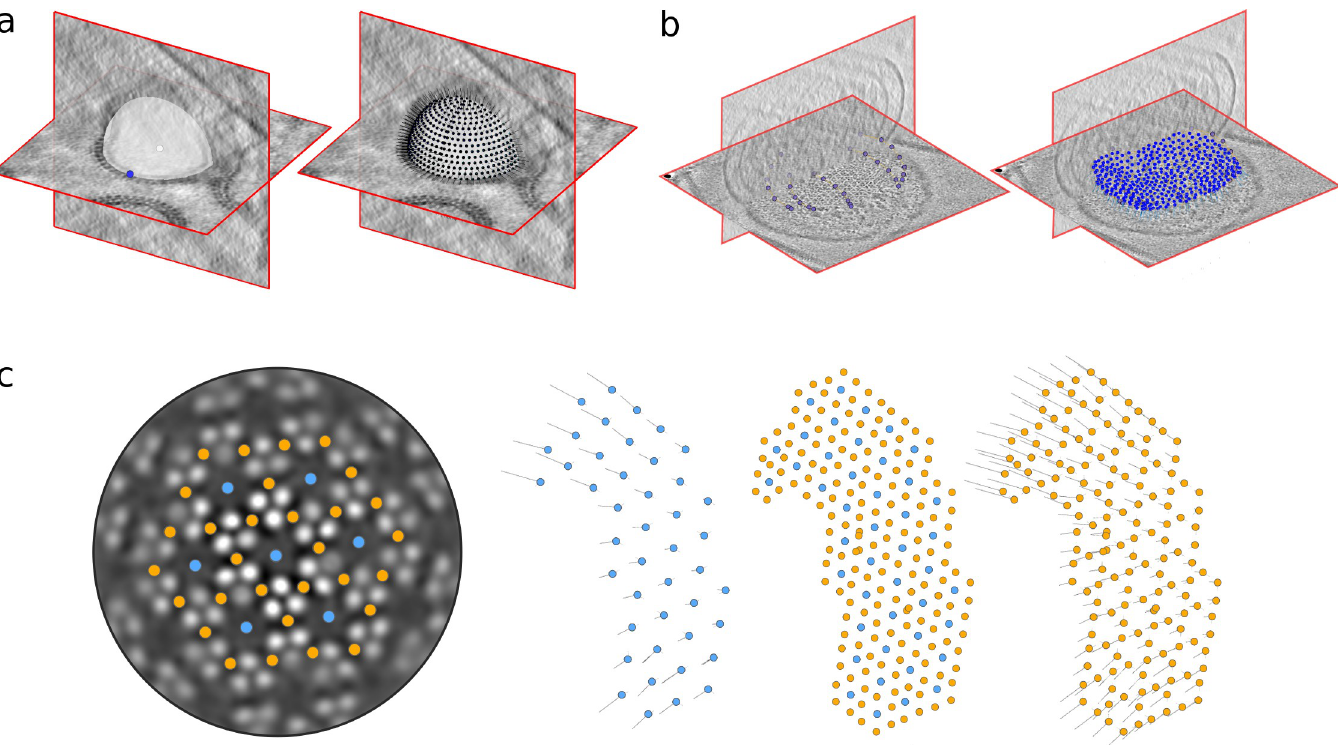
Fig 4. Geometrical approaches to STA. Particle positions and orientations are generated from minimal manual annotations. In (a), a sphere is defined by a center and edge point, and positions with an orientation normal to the surface are seeded on the sphere. In (b), an arbitrary surface is defined by annotation of points on that surface in a number of tomographic slices. A supporting mesh is derived from these points on which a set of particle positions and orientations are seeded, again with an orientation normal to the surface. (c) Different positions in a chemosensory array (EMD-10160; see also below) are annotated in blue and orange. A set of particle poses from an STA experiment (blue) is used to derive the positions and orientations of the orange particles in a “subboxing” procedure. STA, subtomogram averaging.